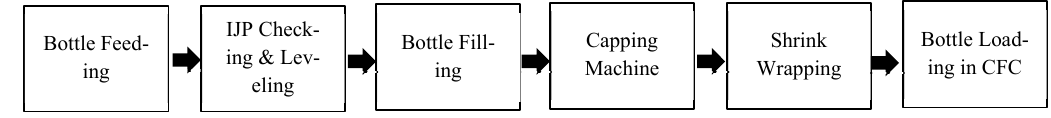
Fig. 2. Workflow of the Filling